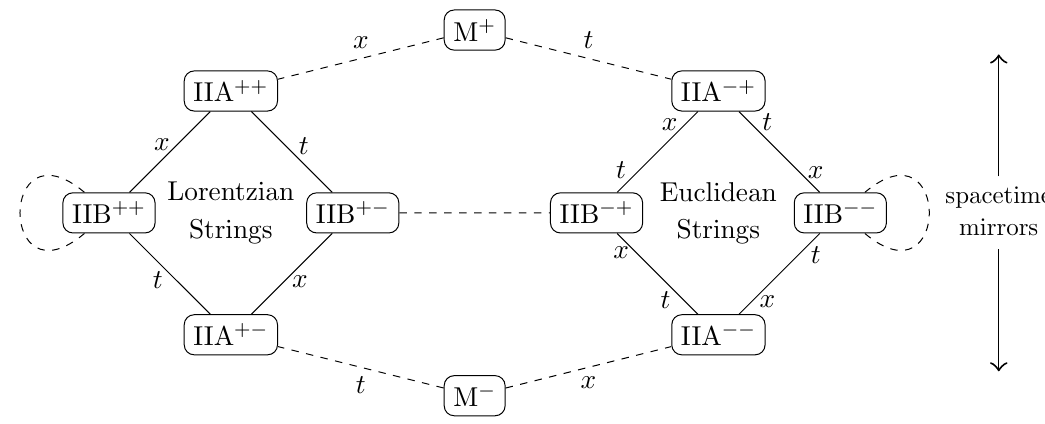
Figure 3 . T-dualities (solid lines) and S-dualities (dashed lines) relating type II string theories and M-theory. In this diagram we suppress the spacetime signature for simplicity (cf. (cid:12)gure 4). The label x ( t ) indicates dualities arising from compacti(cid:12)cation on a spatial (timelike) circle. The left (right) diamond consists of theories with Lorentzian (Euclidean) F-strings. Theories above and below the center line are related by exchanging space and time directions, see